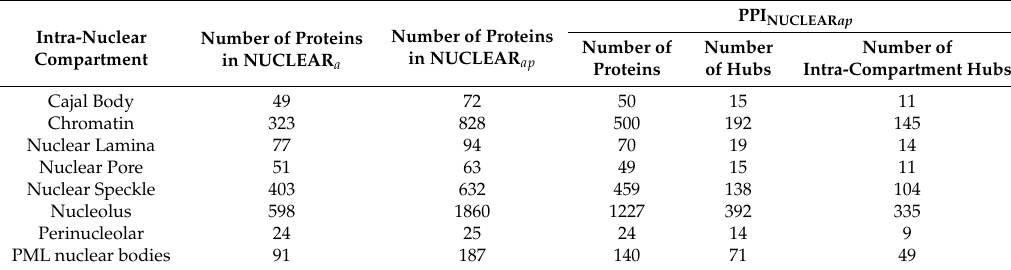
Table 3. Number of proteins and hubs in the intra-nuclear